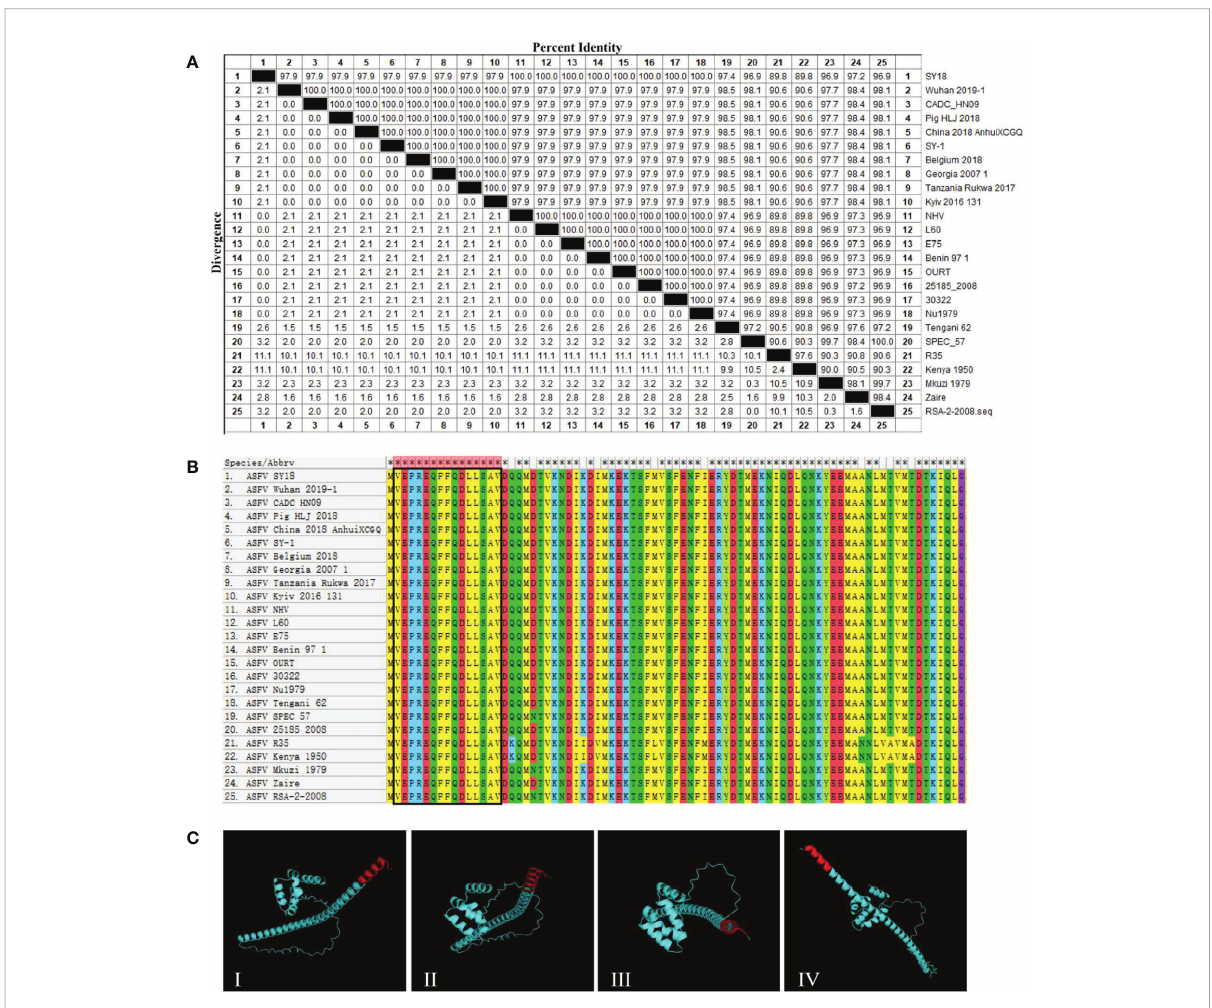
FIGURE 4 2H11 recognized the conserved epitope of ASFVpK205R. (A) The percent identity of pK205R among the 25 representative ASFV strains was analyzed using MEGA. (B) Alignment analysis of the epitope ( 2 VEPREQFFQDLLSAV 16 ) in 25 representative ASFV strains. (C) Prediction of the pK205R structure using PyMOL. The epitope recognized by 2H11 is displayed in red